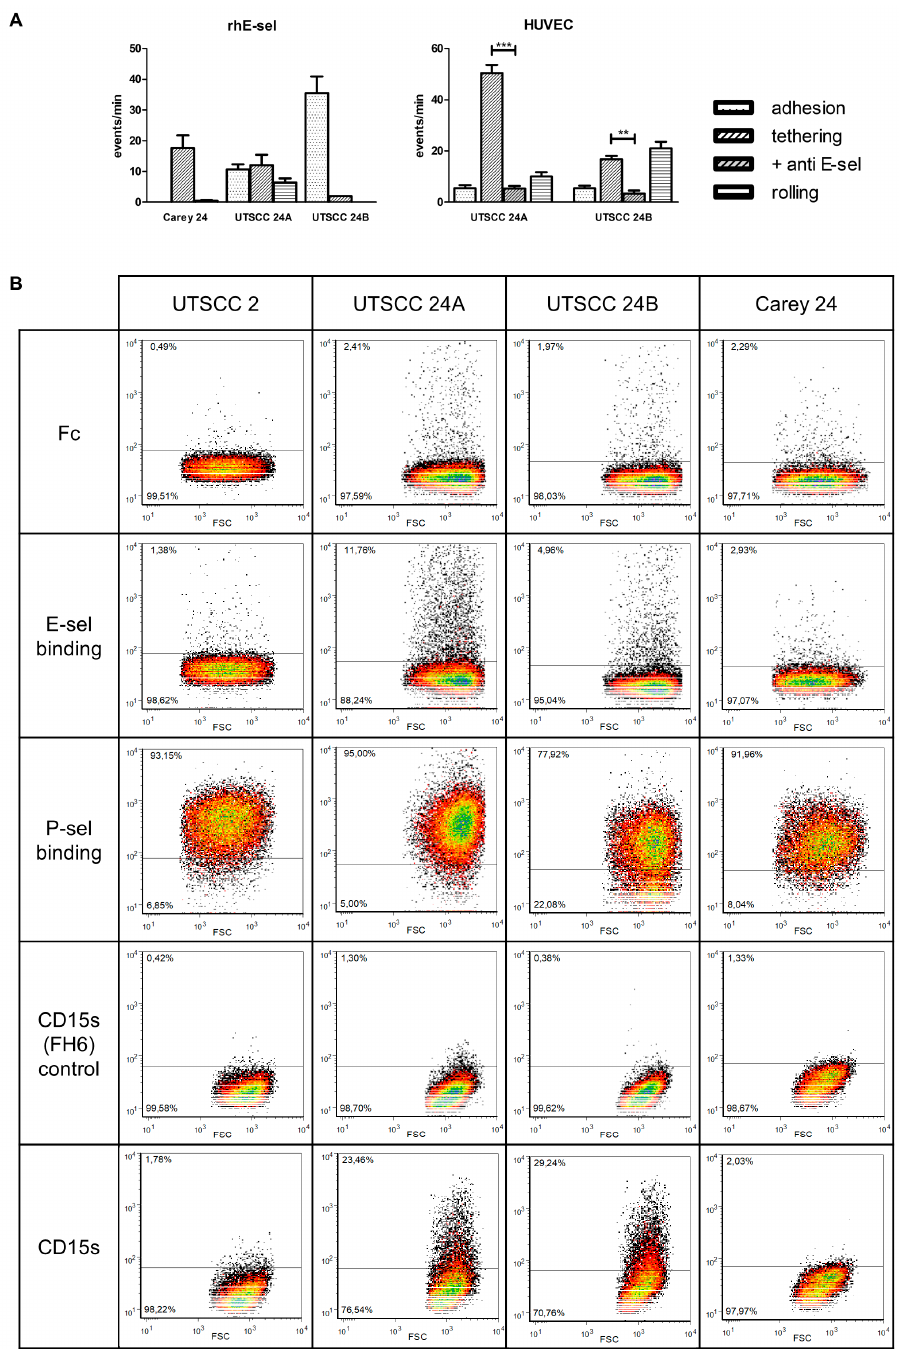
Figure 2. ( A ) Cell flow analysis of human head and neck squamous cell carcinoma cell lines (HNSCC) cells on rhE-selectin-Fc-chimera and on confluent monolayers of IL-1 α -stimulated and unstimulated human umbilical vascular endothelial cells. UTSCC 24B cells most strongly adhered to rhE-sel, and UTSCC 24A cells showed the highest number of adhesive events for stimulated HUVECs. Incubation with the adhesion blocking anti-E-selectin mAb significantly reduced the tethering of UTSCC 24A and tethering and rolling of UTSCC 24B cells to HUVECs (* p < 0.05, ** p < 0.01, *** p < 0.001). ( B ) Representative flow cytometric histograms of selectin binding and canonical selectin ligand expression. All HNSCC cells bound to rhP-selectin, but only UTSCC 24A and B cells bound to rhE-selectin. HNSCC cells did not express CA19-9 (sLeA), but 23% of UTSCC 24A and 29% of UTSCC 24B cells expressed CD15s